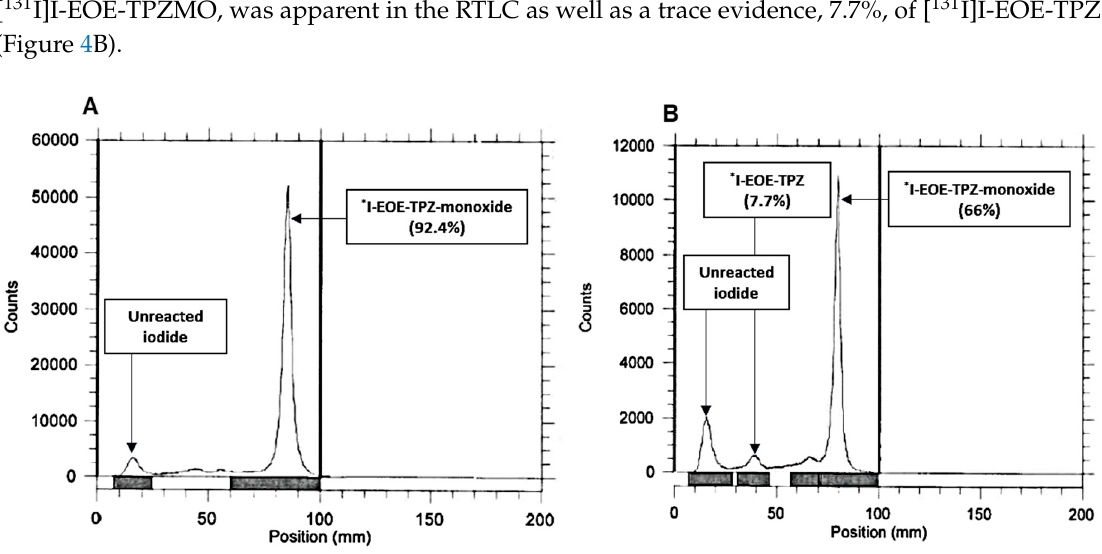
Figure 4. RTLC of the post-labelling exchange reaction mixture using precursor P2 in ACN and pivalic acid after 30 min ( A ) and 60 min ( B ) at 50 °C.